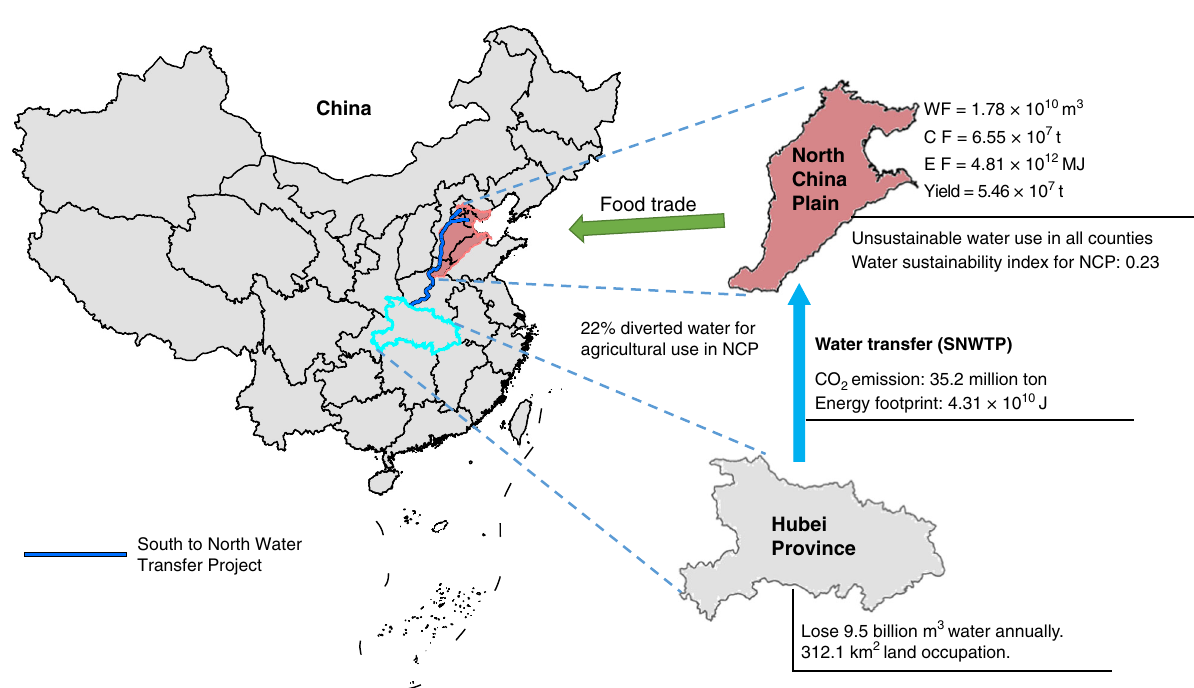
Fig. 1 Metacoupling processes and associated environmental impacts. This Figure shows environmental impacts across the associated food sending system [North China Plain (NCP)], spillover system (Hubei Province), and receiving system (the rest of China). Note: An index value greater than 1 indicates sustainable food supply from the NCP or water use in the NCP. Only irrigation water use is considered in the NCP. The 9.5 billion m 3 /year water is the total water diverted by the South-to-North Water Transfer Project and 22% of the water went toward agricultural use in the NCP 89 . In other words, Hubei Province lost 9.5 billion m 3 of water annually. The data for the base map was derived from the Resource and Environment Science and Data Center (http://www.resdc.cn/) which is publicly available. The boundary of the North China Plain and the route of the South-to-North Water Diversion Project were created by the authors (via ArcGIS version 10.1,